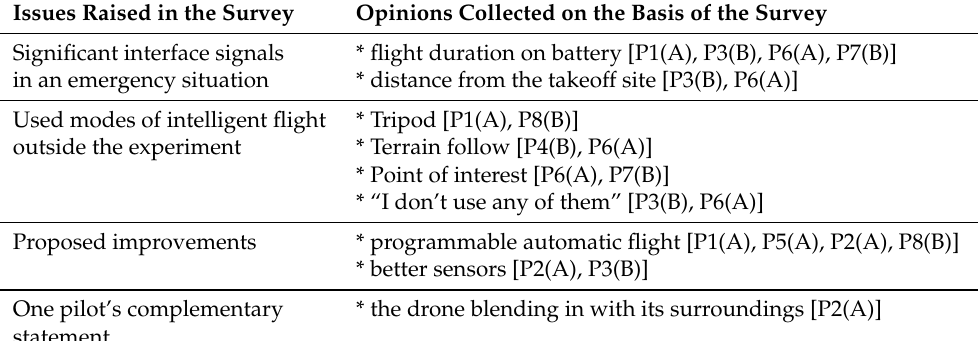
Table A1. Cont. Issues Raised in the